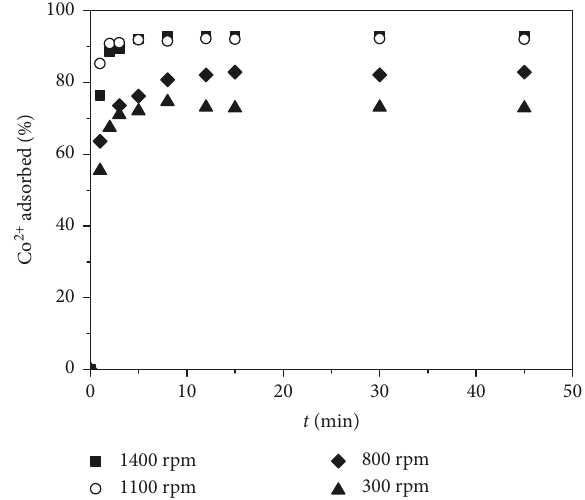
Figure 8: Effect of the agitation speed on cobalt adsorption using MCSG60A. Conditions: [Co 2+ ] sorbent dosage